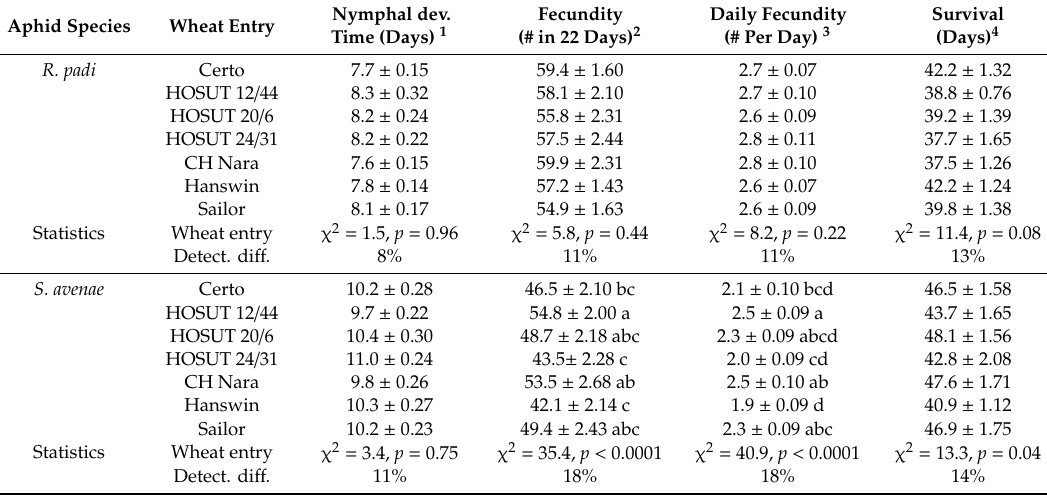
Table 1. Life-table parameters of Rhopalosiphum padi and Sitobion avenae reared on 3 transgenic HOSUT winter wheat lines, Certo (non-transformed parental cultivar), or conventional Swiss cultivars (CH Nara, Hanswin, Sailor) in the greenhouse. Values are means and standard errors, N = 30 replicates per wheat entry. Means followed by di ff erent letters are significantly di ff erent. Detect. di ff . indicates an estimate of the statistically detectable di ff erence with α = 0.05 and power = 0.8 based on means, SDs, and Ns of the parental cultivar Certo and simple t -tests, regardless of the model that was deployed for the actual